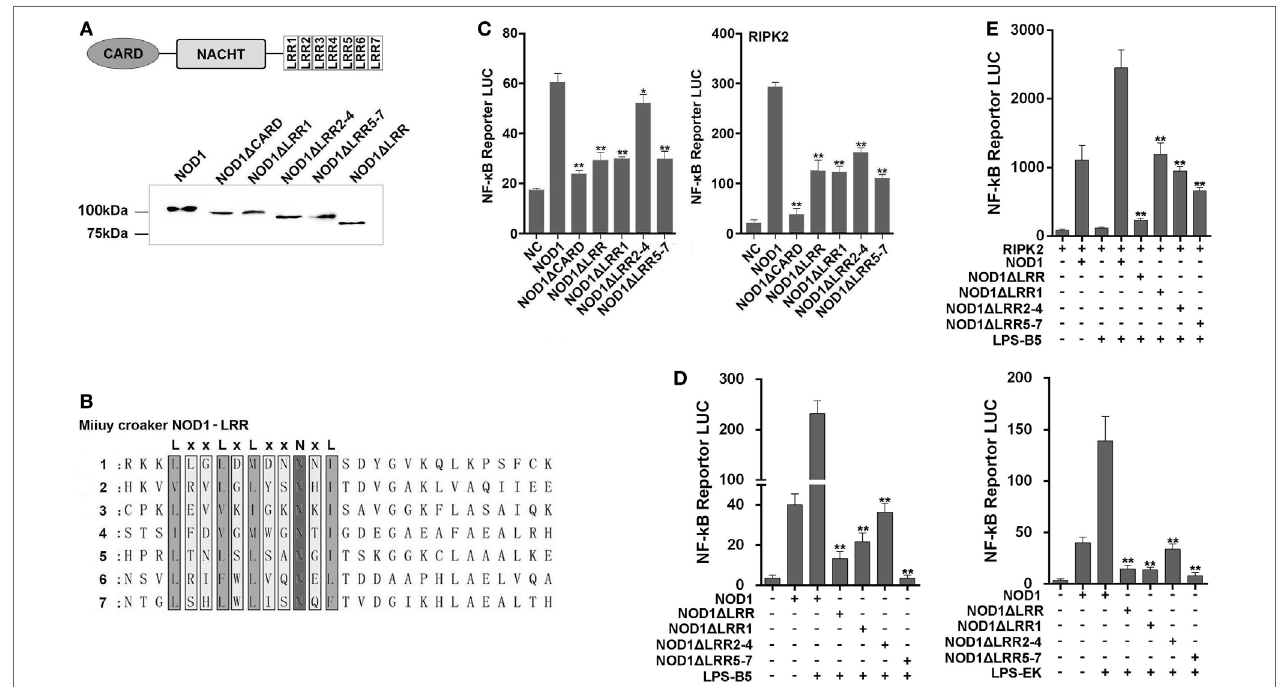
FigUre 9 | Mutant NOD1 cannot recognize lipopolysaccharide (LPS) and activate NF- κ B signaling pathway. (a) HEK293 cells were transfected with wild type and mutant miiuy croaker NOD1 plasmids, respectively, and after 48 h of transfection, the cells were cleaved and western blotting analysis was performed. A cropped NOD1 and several mutant NOD1 blot are shown. For un-cropped blots, see Figure S6 in Supplementary Material. (B) The sequence analysis of miiuy croaker NOD1-LRR domain. (c) HEK293 cells were co-transfected with wild type or mutant NOD1 plasmids along with NF- κ B reporter plasmid and miiuy croaker RIPK2 plasmid, pRL-TK plasmid was used as the internal control, after 48 h of transfection, and the luciferase activity was detected. (D) The cells were co- transfected of wild type or mutant NOD1 plasmids along with NF- κ B reporter plasmid, pRL-TK plasmid was used as the internal control, then the cells were stimulated with LPS-B5 and LPS-EK, after 12 h of stimulation, the cells were collected to detect the luciferase activity. (e) HEK293 cells were transfected with NOD1 or mutant expression plasmid along with NF- κ B reporter plasmid and RIPK2 expression plasmids, next, the cells were stimulated with LPS-B5, after 12 h of stimulation, cells were collected to detect the luciferase activity. All data were shown as mean ± SE, and the statistically significant differences were indicated by asterisks (* P < 0.05 and ** P <